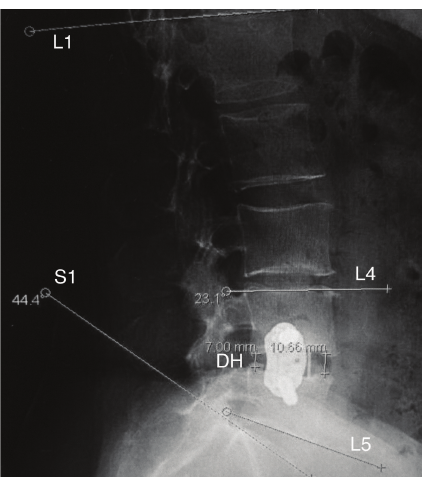
Figure 2: Representative lordosis and disc height measurements. Regional Cobb angles are based on the superior endplate of L1 and the superior endplate of S1 to measure regional lumbar lordosis. Segmental Cobb angles are based on the superior endplate of the rostral vertebral body and the inferior endplate of the caudal vertebral body (L4 and L5 in this example). Disc heights are calculated using the average between the anterior and posterior disc heights.